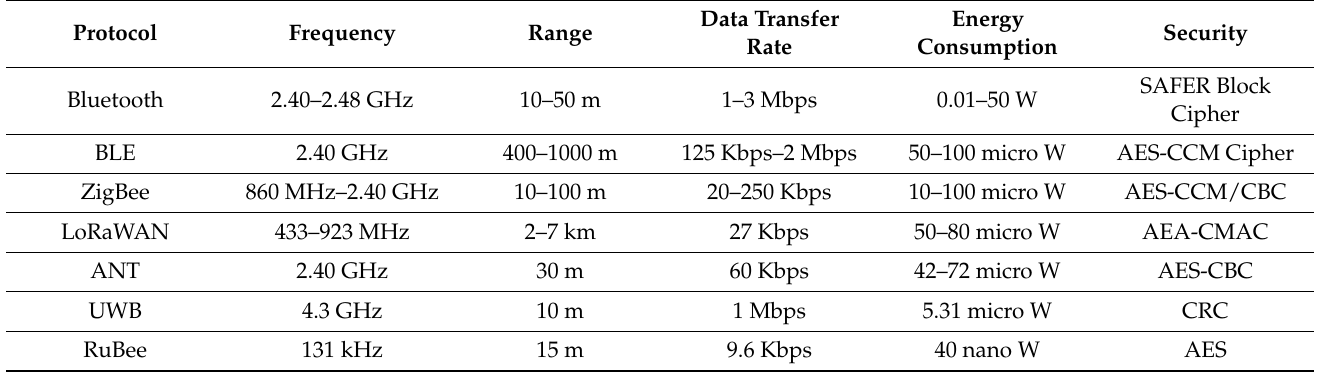
Table 3. IoHT Devices Technical